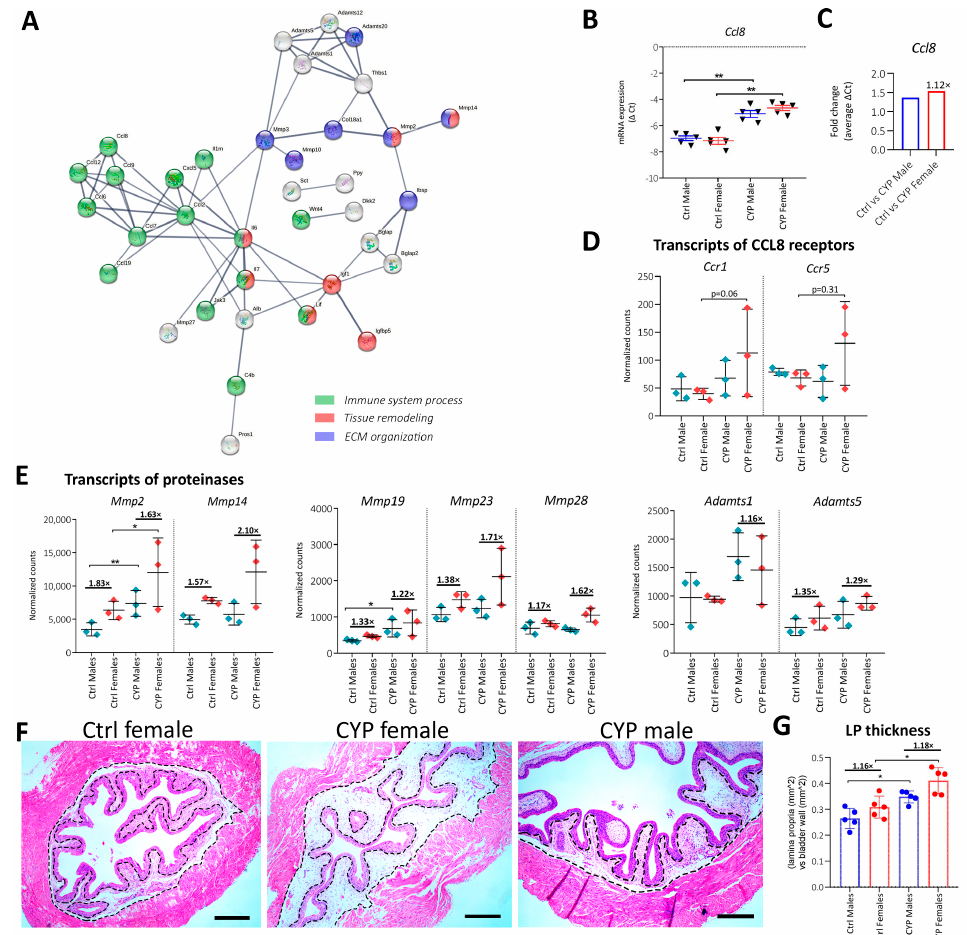
Figure 7. CYP-induced changes in the bladders of female mice. ( A ) STRING network shows interactions between the putative proteins of the significantly DEGs identified in the enriched GO cellular components of the extracellular region, extracellular matrix, and extracellular region part ( n = 56), displaying only interactions of high confidence (0.7). The proteins are known and predicted to interact in immune system processes (green), tissue remodeling (red), and EMC organization (blue). Disconnected nodes are hidden. ( B ) The mRNA expression of Ccl8 shows significant upregulation of the transcript in females after CYP treatment. Shown are the means ± SD of negative ∆ Ct determined for five animals per group. ( C ) Differences in expression of Ccl8 mRNA in males and females after CYP treatment. The fold change of average ∆ Ct in Ctrl vs. CYP males and Ctrl vs. CYP females is represented on the y axis. The number written above the bars indicates the fold change in mRNA expression in females vs. males after CYP treatment. ( D ) mRNA expression of Ccr1 and Ccr5 demonstrates a greater increase in females compared to males after CYP treatment. Shown are the mean ± SD of normalized read counts determined by RNA seq for three animals per group. ( E ) mRNA expression of selected proteinases ( Mmp2 , Mmp14 , Mmp19 , Mmp23 , Mmp28 , Adamts1 , Adamts5 ) demonstrates a greater increase in females before and after CYP treatment compared to males. Shown are the mean ± SD of normalized read counts, determined by RNA seq for three animals per group. Blue lines indicate the fold change in average read counts between the groups (Ctrl males vs. Ctrl females and CYP males vs. CYP females). ( F ) Representative images of HE-stained bladder sections showing the difference in LP thickness between Ctrl female, CYP female, and CYP male. Dotted-line borders the measured surface area of LP. Scale bars: 250 µ m. ( G ) Quantitative analysis of LP thickness reveals a greater thickness of LP in females compared to males before and after CYP treatment. Blue lines indicate the fold change in average LP thickness between the groups (Ctrl males vs. Ctrl females and CYP males vs. CYP females). * p < 0.05; ** p <